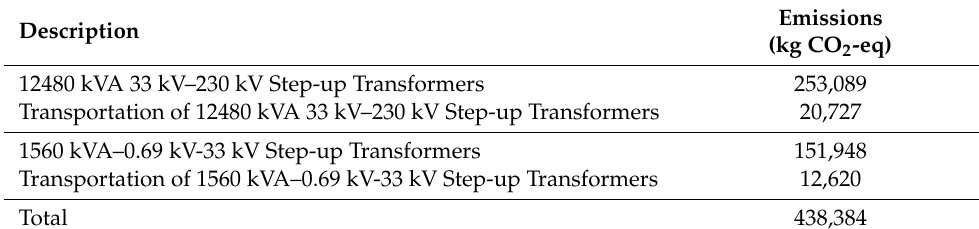
Table 5. GHG emissions associated with transformers.